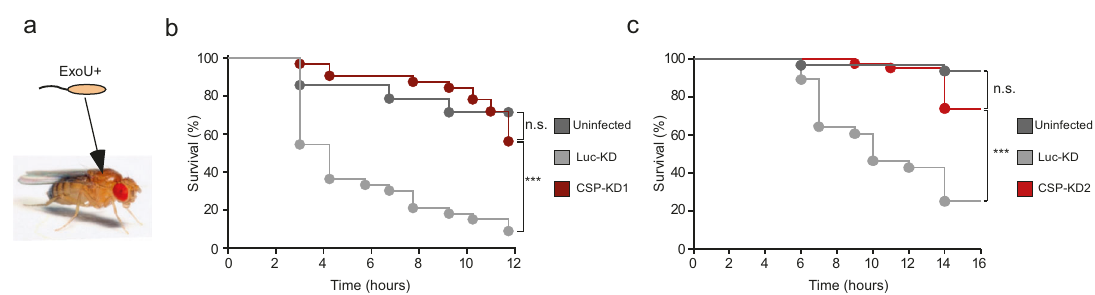
Fig. 2 ExoU toxicity in Drosophila requires CSP (DNAJC5 orthologue). a Drosophila were infected with PP34 (ExoU + ) by pricking the thorax with a thin needle dipped in bacterial suspension. b Flies expressing RNAi transgenes targeting either the fi re fl y luciferase gene (Luc-KD, n = 33) or the Csp gene (CSP- KD1, n = 40) were infected with PP34. c Similar experiment with Luc-KD ( n = 28) and CSP-KD2 ( n = 51) infected with PP34. Mock-infected CSP-KD1 ( b , n = 30) or CSP-KD2 ( c , n = 47) fl ies were included as negative control (uninfected). Fly survival was recorded and data are represented as Kaplan – Meyer curves. Multiple comparisons tests (LogRank) gave a p-value of 0.0001 for ( b , c ). Simple LogRank comparison tests were performed: n.s., non-signi fi cant; *** p < 0.0001. Source data are provided as a Source Data fi